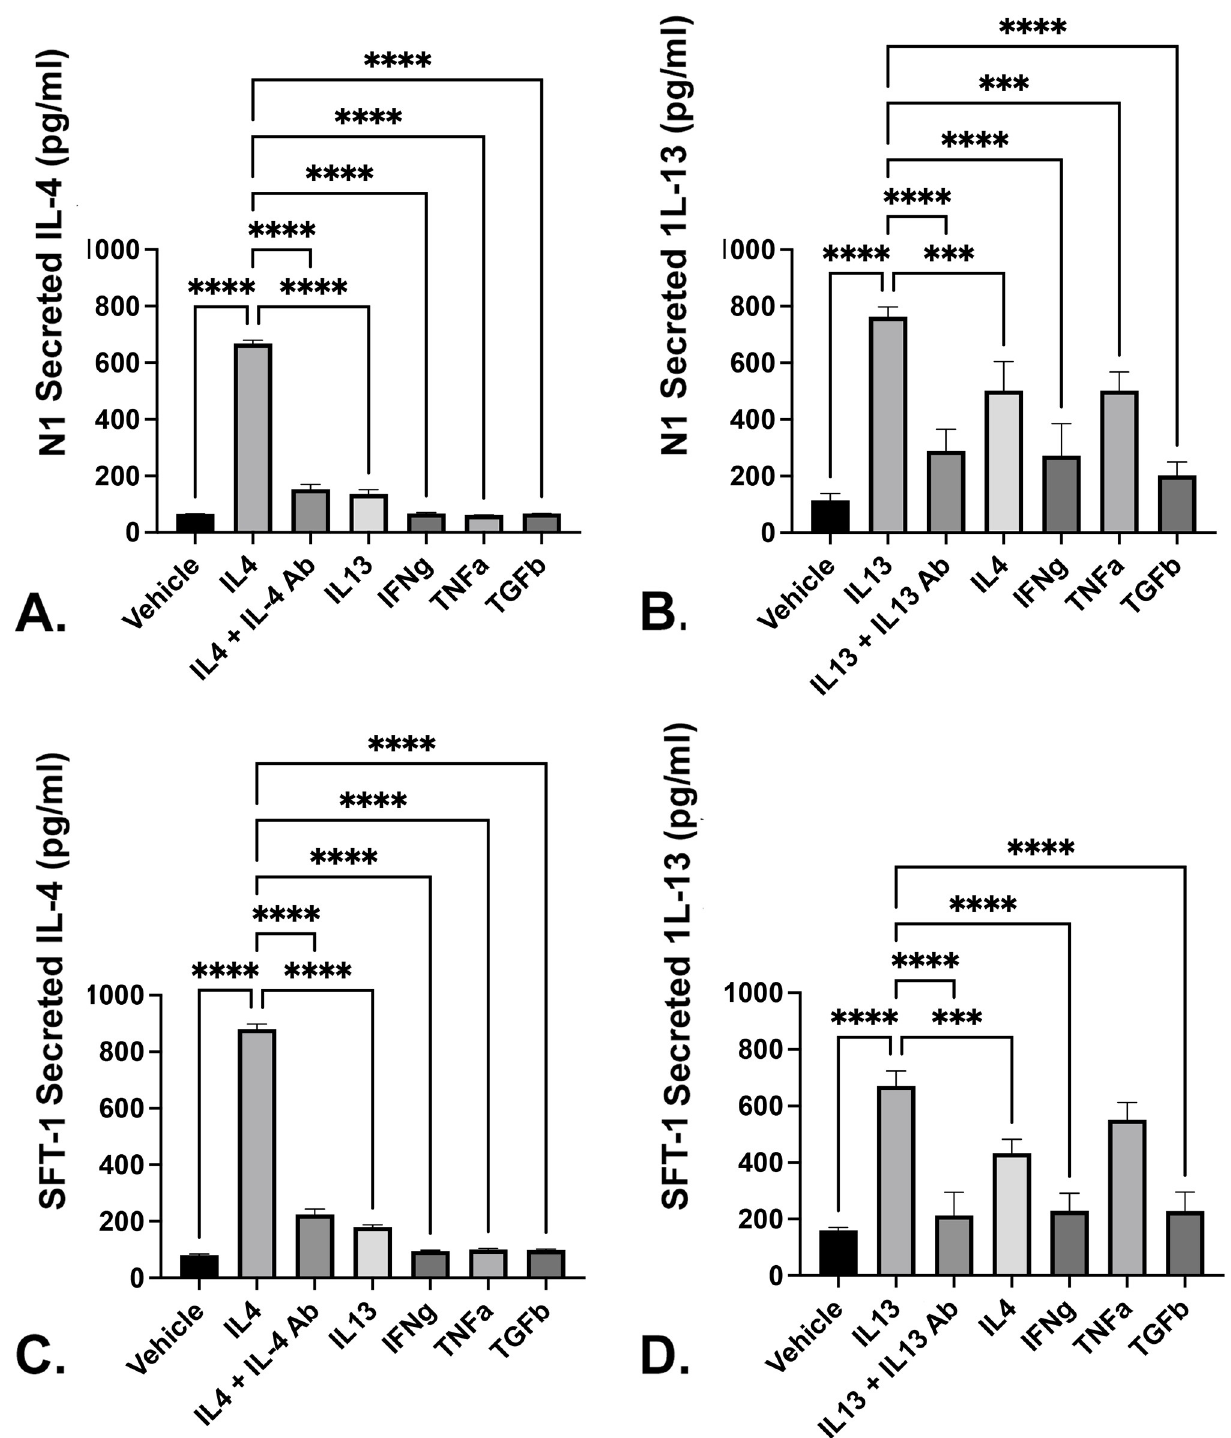
Fig 3. IL-4 and IL-13 induce self expression in prostate fibroblasts. N1 or SFT1 prostate fibroblasts were cultured in serum-free media supplemented with vehicle or 20ng/ml IL-4, IL-13, IFN- γ , TNF α , or 4ng/ml TGF- β , for 24 hours with or without 2 hr pre-treatment with 400 ng/ml IL-4R α or 40 ng/ml IL-13R α 1 antibody. The cells were then washed, switched to fresh serum-free media, and incubated for another 24 hrs. Conditioned media was collected and interrogated by ELISA for IL-4 or IL-13 protein secretion (N1 cells, A and B ; SFT1 cells, C and D ) (S3 Fig), respectively. Statistically significant differences between IL-4 or IL-13 secretion by vehicle-treated compared to other treatments is indicated as � p < .05; �� p < .01; ��� p < .001; ���� p < .0001.